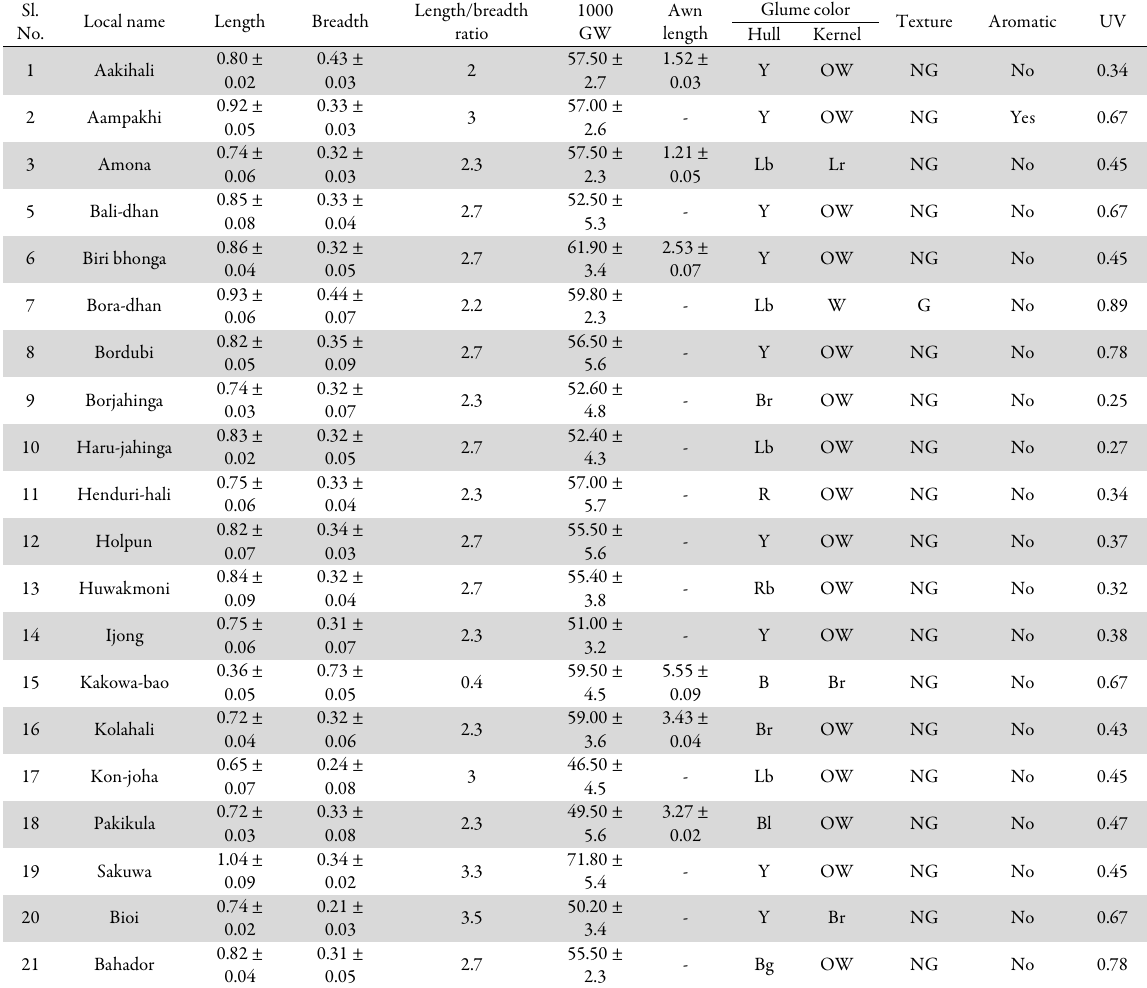
Table 1. Diversity of rice and seed description of the collected indigenous rice varieties from Lakhimpur, Assam Sl.